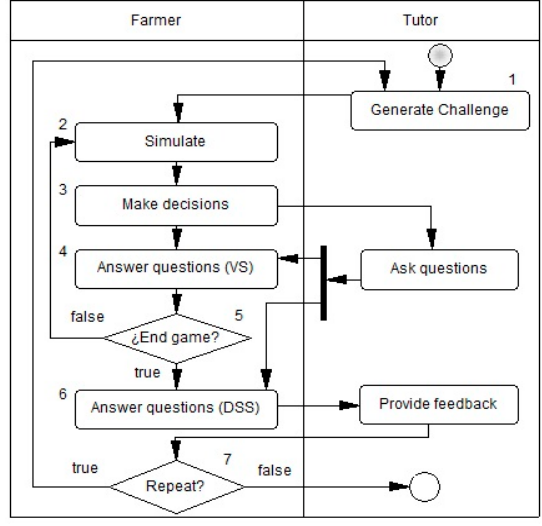
Figure 7. Steps of phase 6 - Training with the game